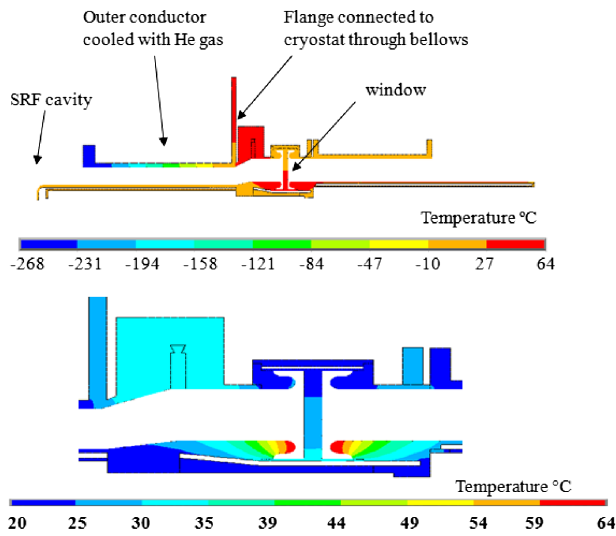
FIG. 4. Top: temperature of the FPC with 1 MW of rf power transmitted through; bottom: temperature contours on the rf window area.